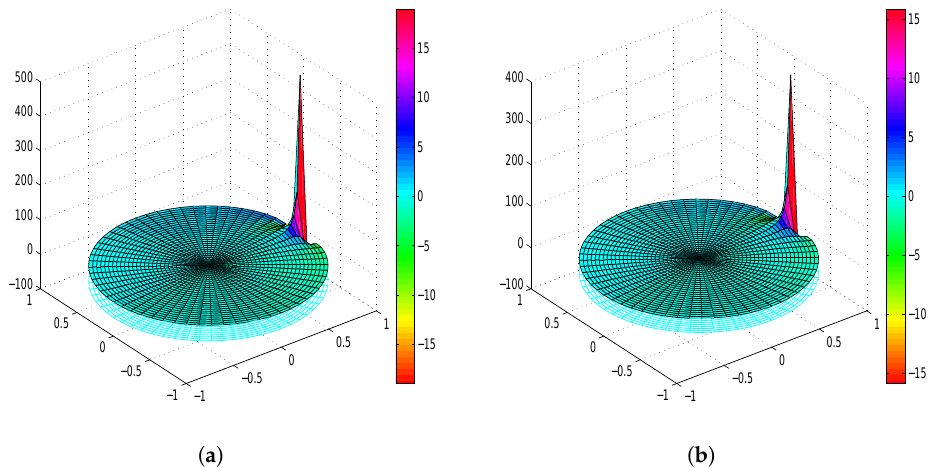
Figure 1. Three dimensional coordinates plus color, the z-axis represents the real part of the function, and the color represents the imaginary part of the function. ( a ) The graph of f 0 1 ( z ) 2 of f 1